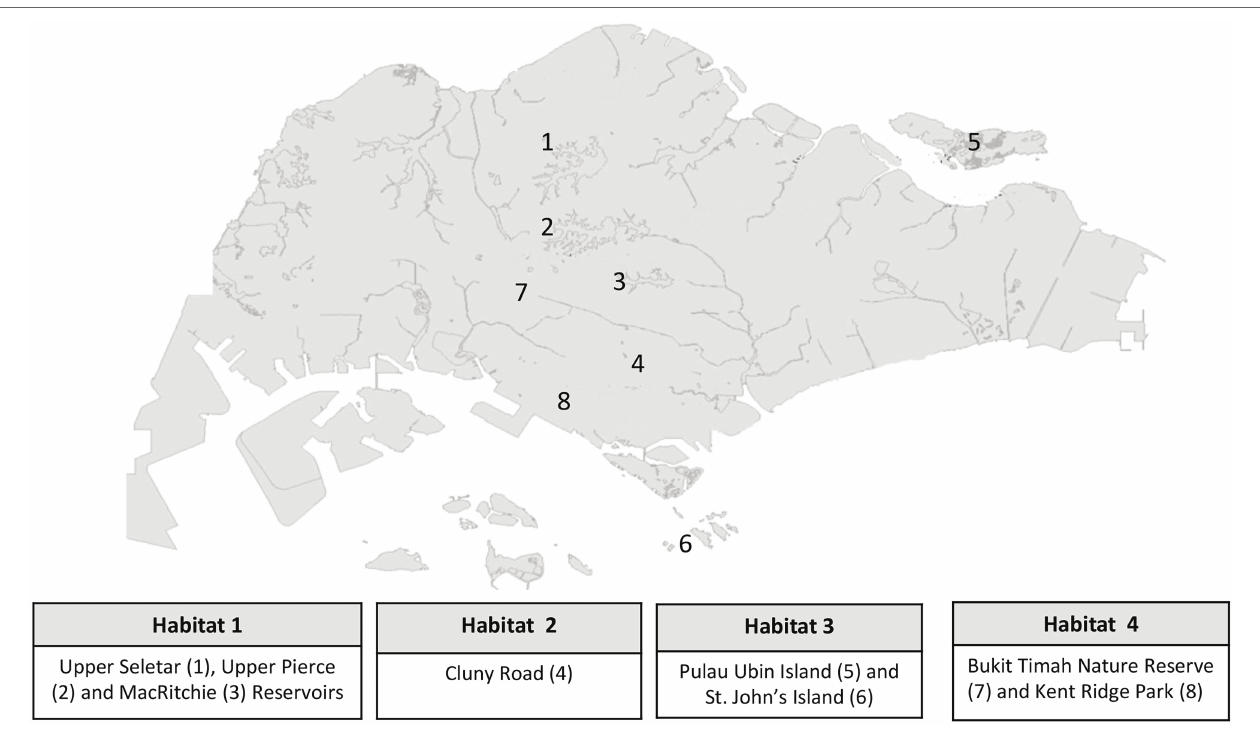
FIGURE 1 | A map of Singapore showing eight locations where the identified fungal endophytes were originally isolated